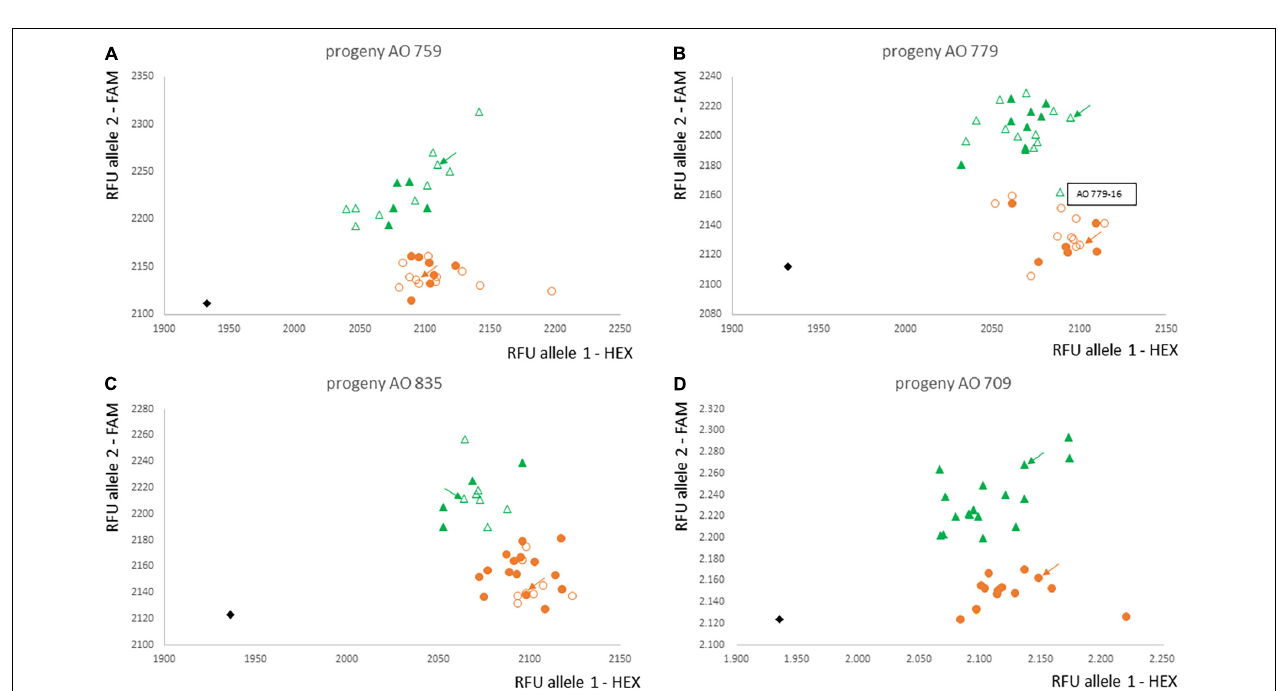
FIGURE 3 | Manhattan plots of the array analysis, resulting from 30 diploid AV-1-resistant BC 3 plants, 30 diploid AV-1-susceptible BC 3 plants, the resistant and susceptible parental plants, and 25 AV-1-susceptible cultivars. (A) For all 10 asparagus chromosomes; (B) Specifically for asparagus Chromosome 2. The genome comparison showed an association of AV-1 resistance with marker Ax-553065352 on asparagus Chromosome 2.